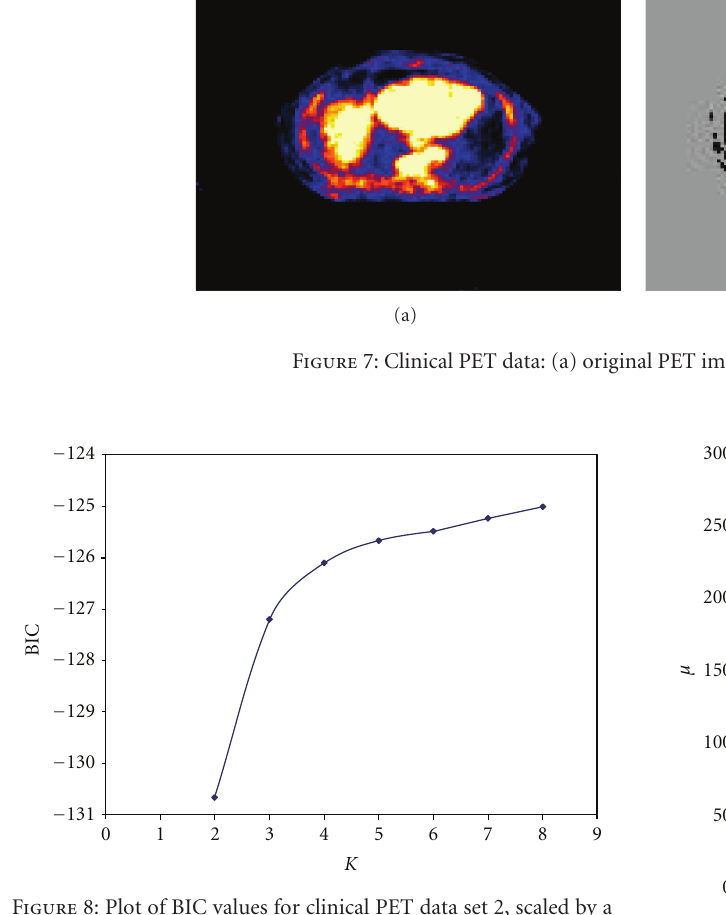
Figure 8: Plot of BIC values for clinical PET data set 2, scaled by a factor of 1000.